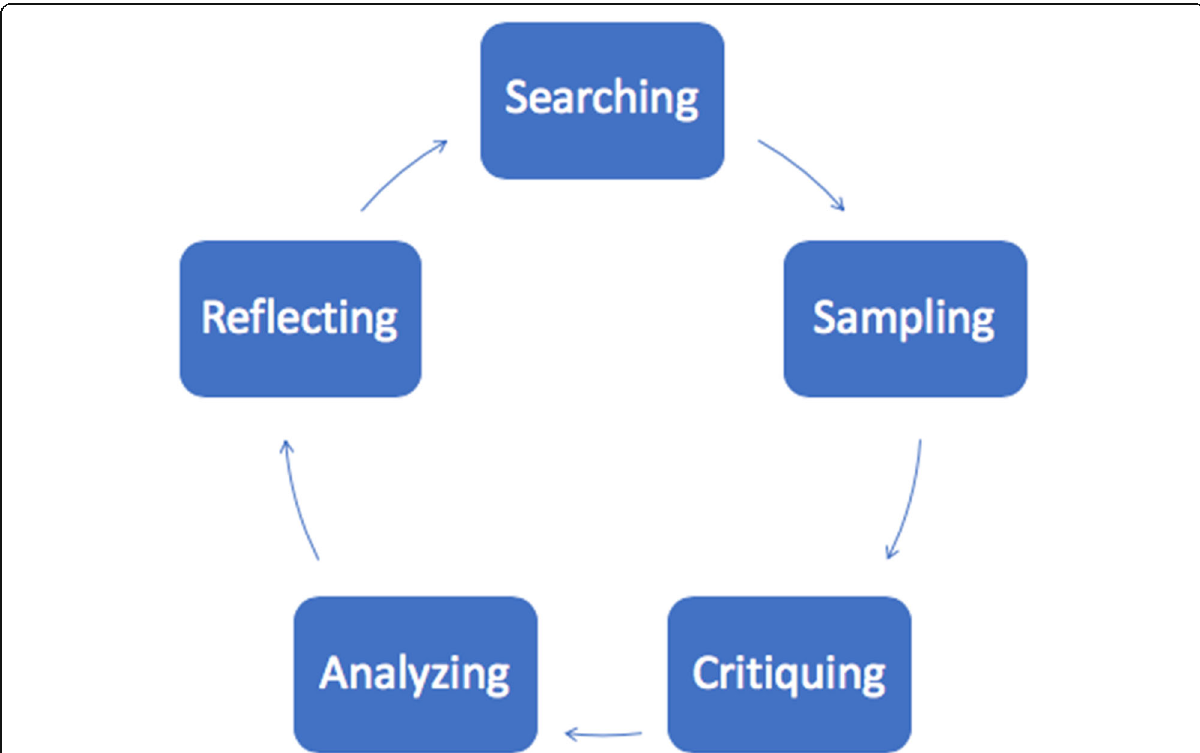
Fig. 1 Critical interpretive sysnthesis (CIS) iterative approach